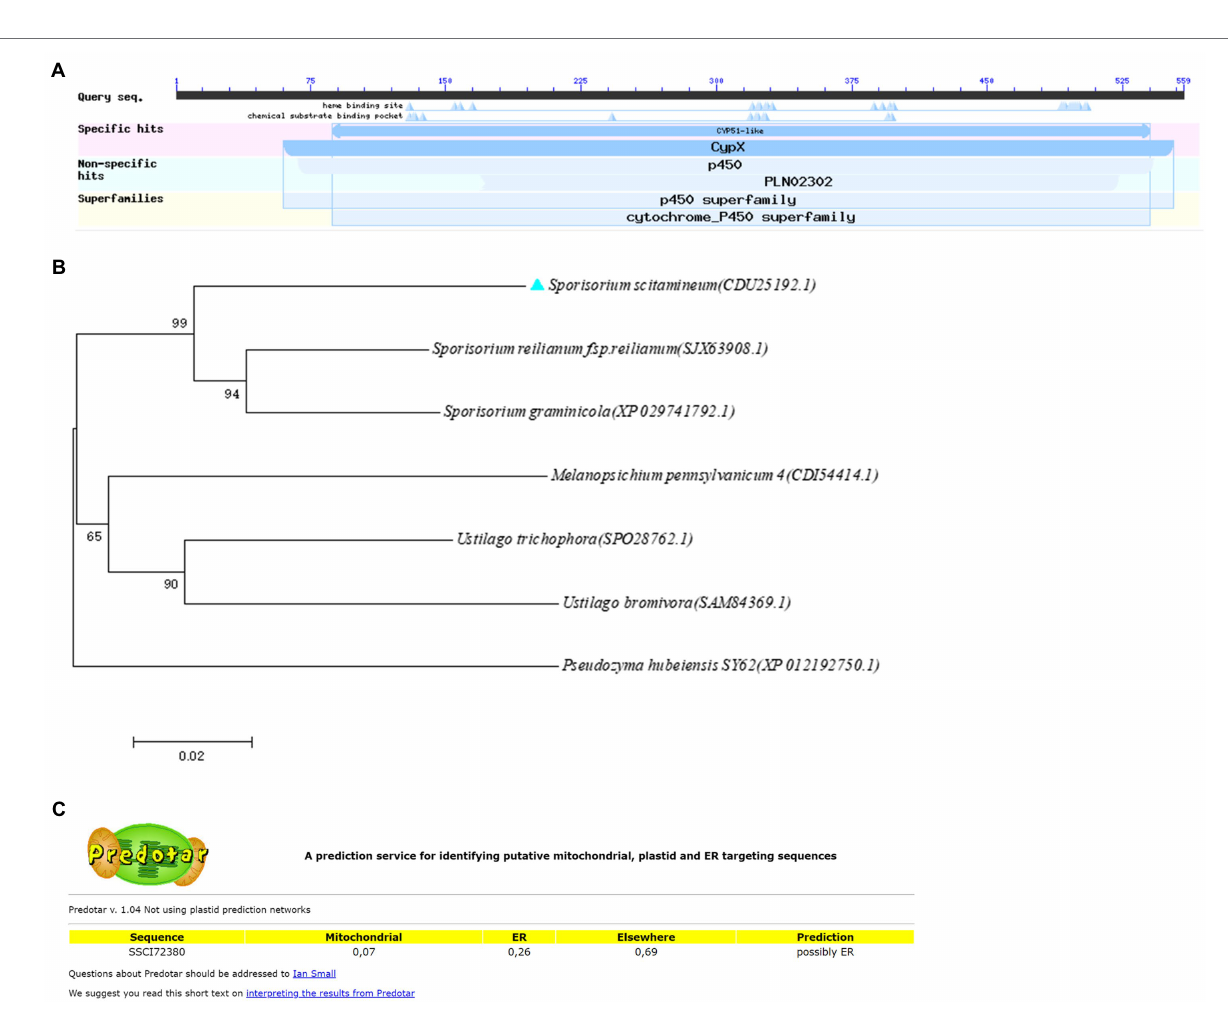
FIGURE 1 | Domain and phylogenetic analysis of SsCI72380 genes encoding sterol 14 α -demethylase in Sporisorium scitamineum . (A) Predicted protein encoded by the SSCI72380 gene was sterol 14 alpha-demethylase (p450 family). (B) Phylogenetic tree analysis of SsCI72380 coding proteins; Arabic numerals at the node edge of the tree indicate the degree of credibility of the phylogenetic tree (using 1,000 bootstrap replicates). Sporisorium scitamineum SsCI72380 is denoted by a blue solid triangle. (C) Prediction of the subcellular structural localization of SsCI72380 gene-coding